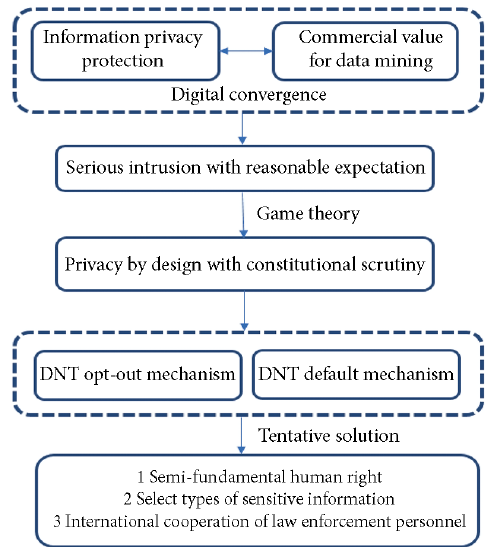
Figure 1. DNT mechanism in marketing applications (source: compiled by